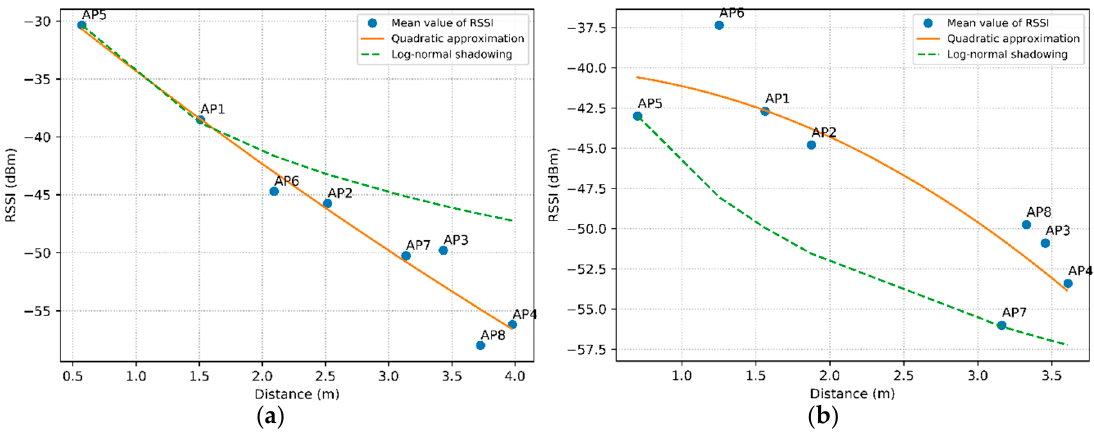
Figure 4. Comparison between log-normal shadowing, quadratic approximation and the average to obtain the received signal intensity indicator. ( a ) Reference point 1 and ( b ) reference point 2.